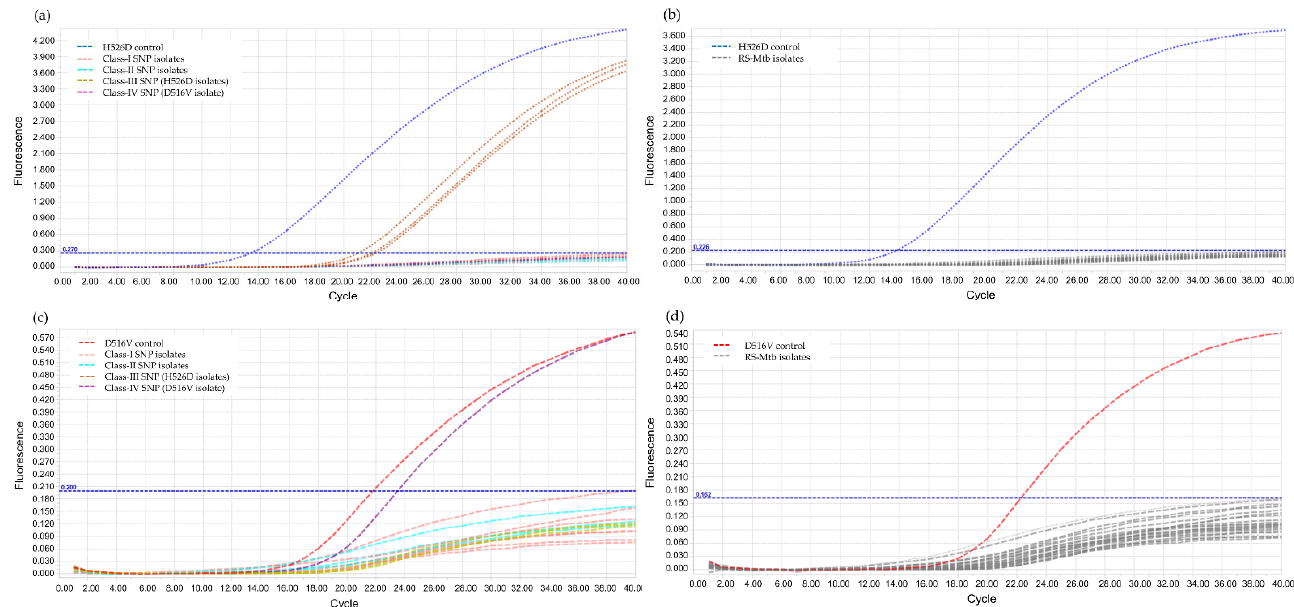
Figure 2. Validation of the RIF-RDp assay for detection of H526D and D516V mutant Mtb strains using 14 rifampicin-resistant M. tuberculosis (RR-Mtb) strains (7, 3, 3, and 1 strain of Class-I, Class-II, Class-III (H526D), and Class-IV SNP (D516V)), 20 rifampicin-susceptible M. tuberculosis (RS-Mtb) strains, H526D and D516V mutant controls, and M. tuberculosis H37Rv reference strain. The fluorescence signal detected in the HEX channel ( a , b ), or Cy5 channel ( c , d ) illustrates the detection of H526D or D516V mutant Mtb strains, respectively.